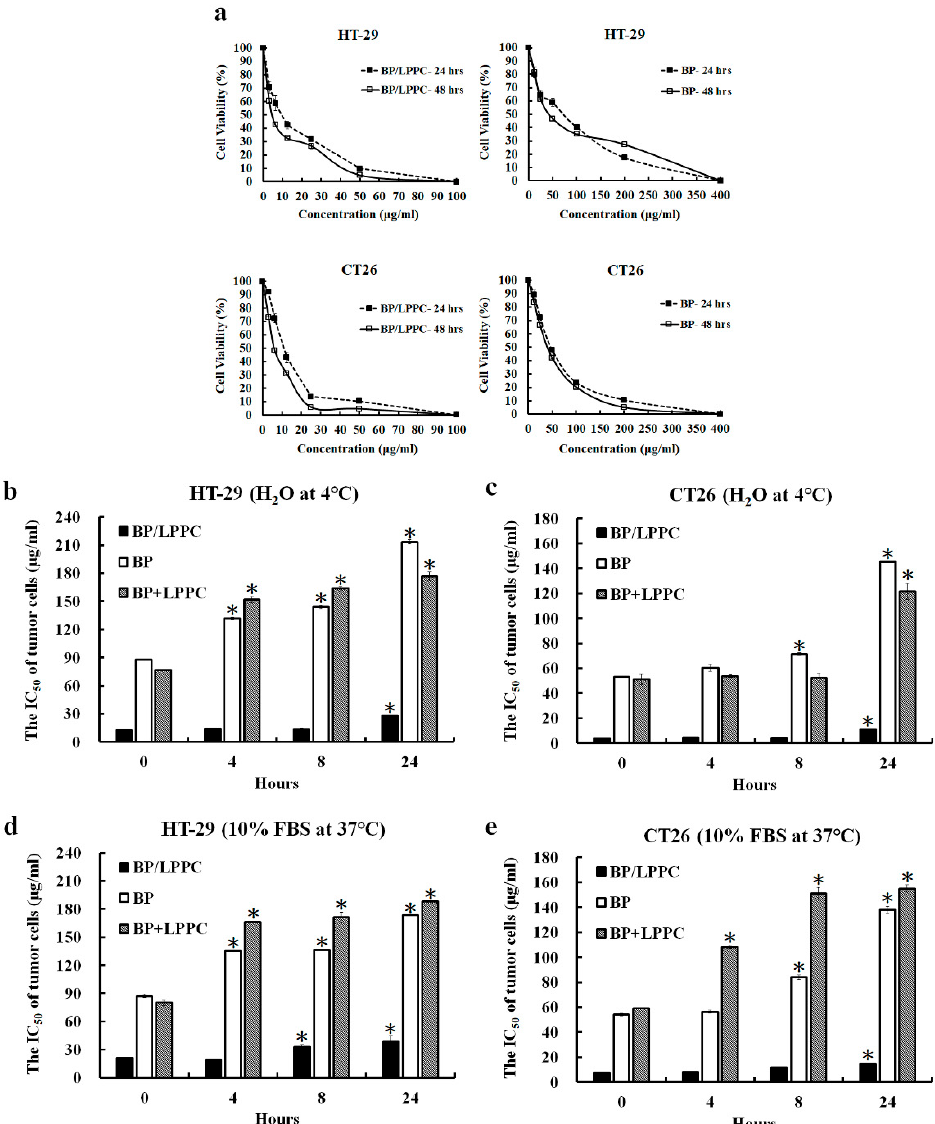
Figure 1. Protective effect of LPPC encapsulation on BP activity. ( a ) Growth inhibition curves of BP/LPPC- or BP-treated cells created based on the results of the MTT assay. ( b – e ) BP/LPPC, BP or BP + LPPC were dissolved in H 2 O at 4 °C or 10% FBS in PBS at 37 °C and incubated for 0, 4, 8 and 24 h. HT-29 and CT26 cells were treated with the preincubated BP/LPPC, BP or BP + LPPC and IC 50 values were calculated using the MTT assay. BP activity was determined by assessing the cytotoxicity toward colorectal cancer cells. * p < 0.05 compared with the 0 h in each group.